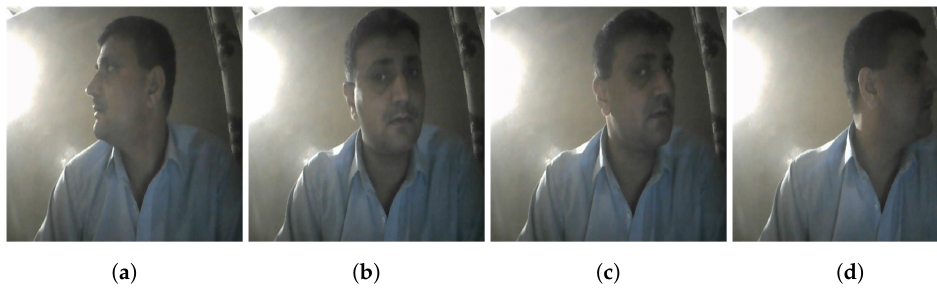
Figure 3. ( a – d ) Frames of the input low quality video.